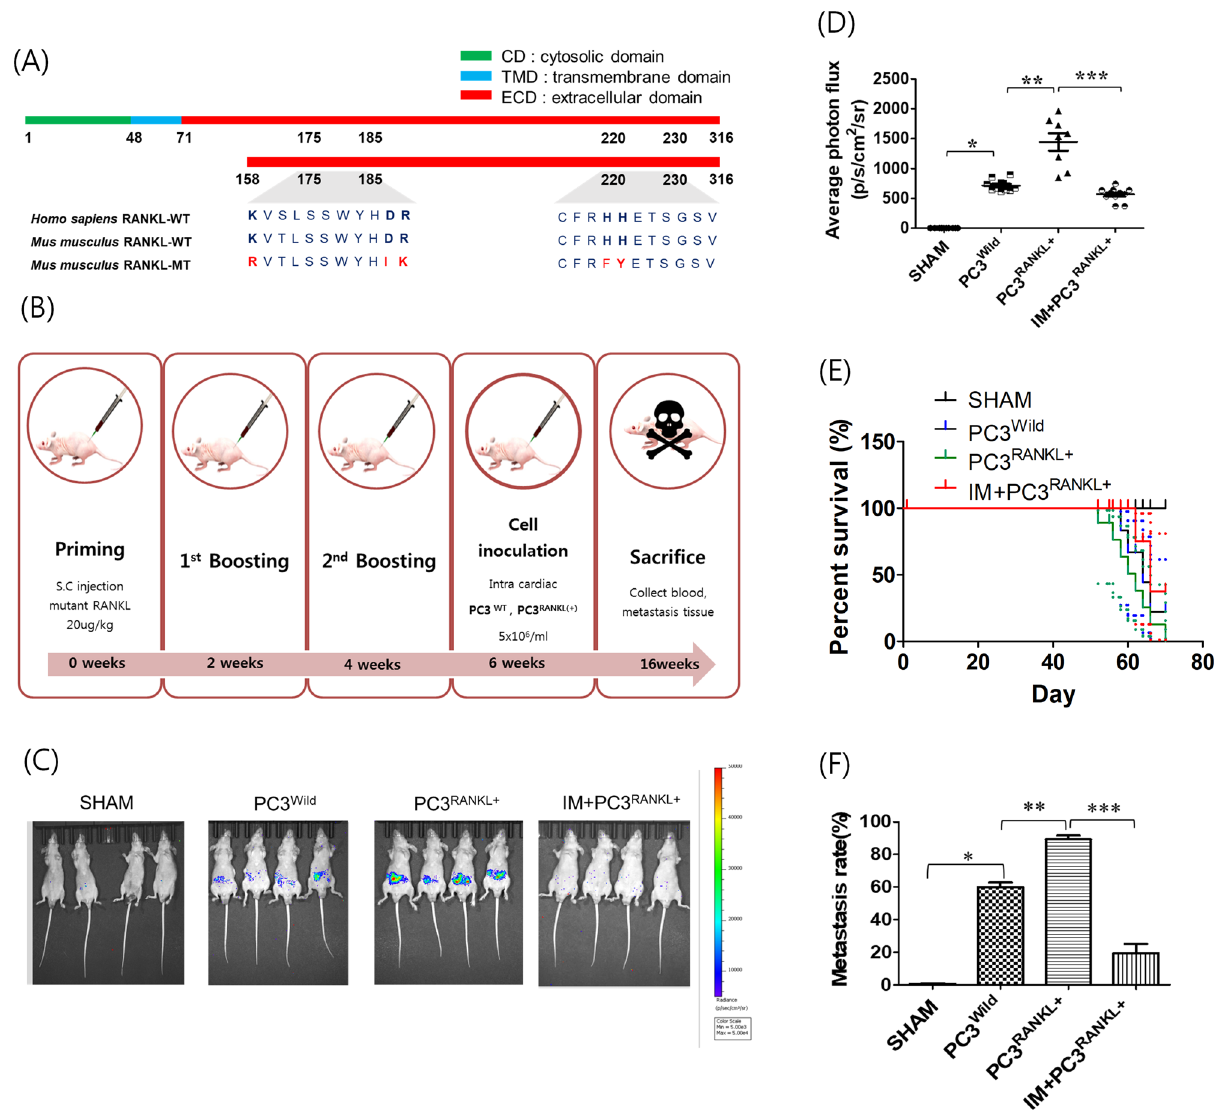
Figure 3. Effects of immunisation with mutant RANKL. ( A ) Comparison of the sequences of hRANKL, mRANKL-WT and mRANKL-MT. ( B ) In vivo experimental flow. Male BALB-c/nu mice (6-weeks-old) were immunised with a subcutaneous injection of test agent (20 μg/kg). ( C ) Tumour growth and metastases were monitored via in vivo bioluminescence imaging of the reporter activity induced by PC3 Wild , PC3 RANKL+ and PC3 RANKL+ + IM treatment. Data per representative mouse are shown. A large hot-spot of bioluminescence was observed in vivo following inoculation of mice with PC3 RANKL+ cells. Multiple localised and distant metastases were observed in vivo after the injection of PC3 RANKL+ cells into the hearts of nude mice. Coloured bars indicate the bioluminescence signal intensity (photon/s/cm 2 /steradian). ( D ) The bioluminescence photon flux that appeared after inoculation of cells into mice is shown graphically. Data from related graphs are displayed as the mean ± SD. ( E ) Survival and ( F ) metastasis rate in mice from the SHAM, PC3 Wild , PC3 RANKL+ and PC3 RANKL+ + IM